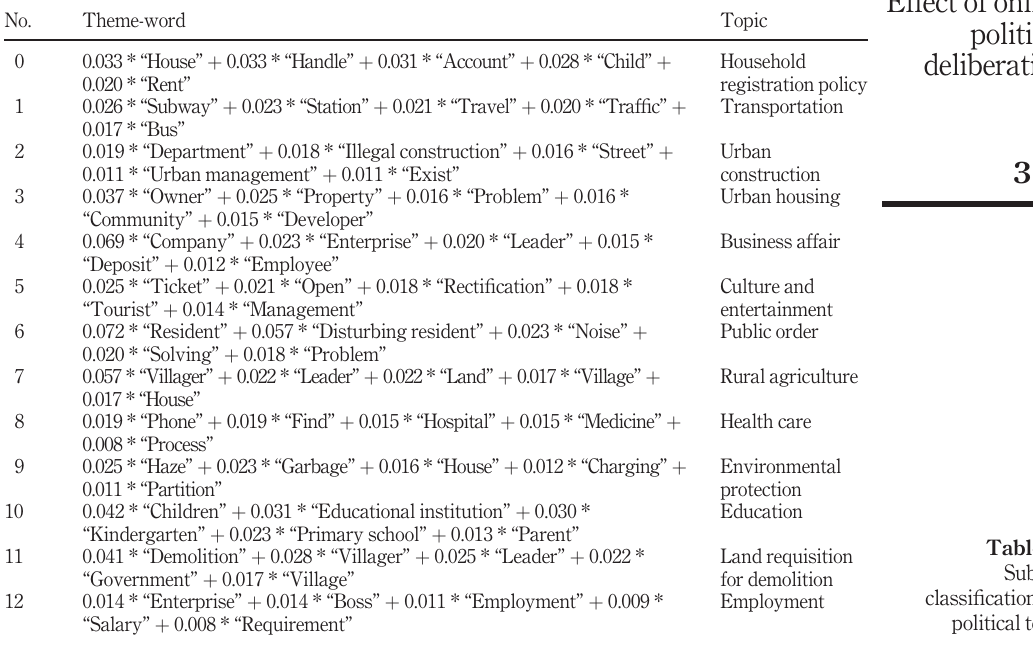
classi fi cations of political